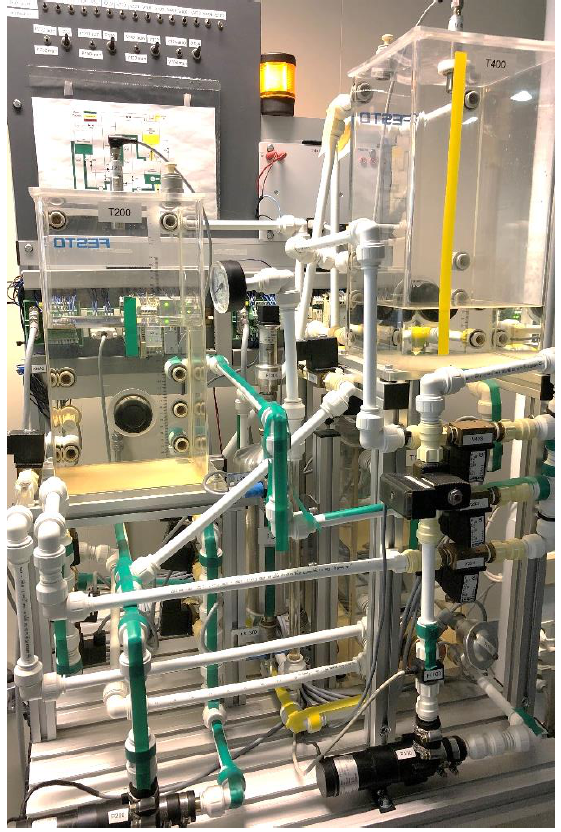
Figure 8. Aalto’s water process plant.